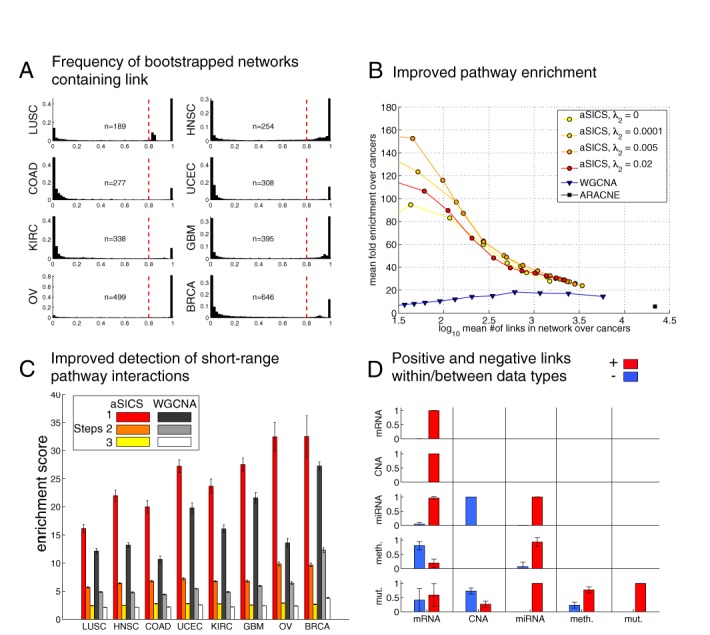
Characterization of cancer-comparative SICS. (A) Bootstrap analysis of network stability. The presented network models are created as a summary of 500 networks made from pseudo-bootstrapped TCGA patient data. The histograms display the frequency of the presence of specific links over the bootstrapped networks for each cancer. The final network is made by selection of links present in >80% of the bootstrap networks (red threshold line). (B) Characterisation of Cancer comparative SICS by pathway overlap, measured as fold enrichment of known links from the database PathwayCommons (Materials and Methods). For a range of network sizes (50–3400 links), augmented SICS achieved 30-fold to 160-fold enrichment. The enrichment of known links depended on both network size (x-axis) and on the cancer differential penalty (Pd, tuned by λ2, see Materials and Methods). (Figure 2b, signed rank test P < 0.01). As a point of reference, the corresponding enrichment was not as high for a standard correlation network (WGCNA, signed rank test, P ≤ 0.0078). A nonparametric reference method (ARACNE) produced considerably denser networks, also at the highest stringency setting, making the comparison difficult. (C) Analysis of direct vs indirect links. We stratified the analysis of pathway overlaps (B, above) into short-range interactions (direct links in PathwayCommons) and long range interactions (second and third order indirect links in PathwayCommons). This showed a marked difference in performance between SICS and WGCNA for direct links (P < 0.0001 for all eight cancers), and a less pronounced but still significant, when comparing indirect (two or three steps) interactions (Figure 2c, P < 0.0001 except for breast cancer). Error bars = 99% CI. (D) Link signs of the SICS model are broadly consistent with biological mechanism. Bar charts display the mean proportion over cancers of negative (blue) and positive (red) links within and between different data types. Eighty percent of methylation-DNA links are negative (plausibly reflecting cis-acting methylation-mediated suppression of transcription) and CNA-mRNA links are positive, plausibly reflecting elevated transcriptional rates of genes with multiple chromosomal copies.